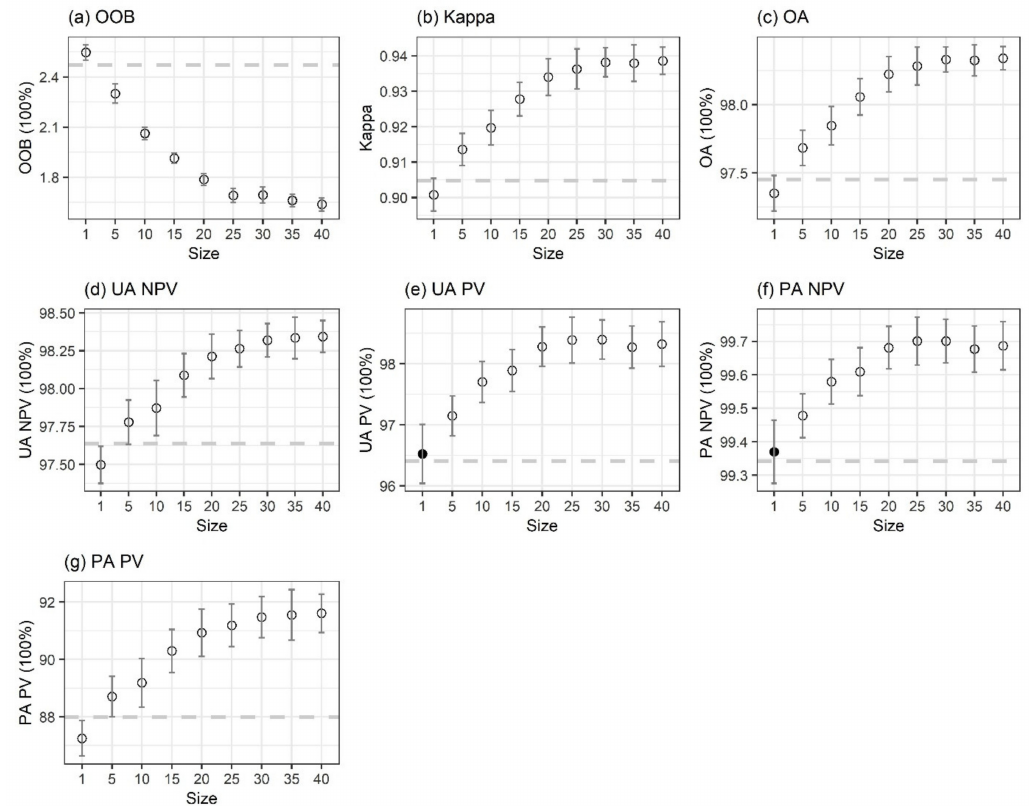
Figure 3. The mean value (dot) and stand deviation (error bar) of ( a ) Out-Of-Bag error (OOB), ( b ) Kappa coefficient, ( c ) Overall Accuracy (OA), ( d ) User’s Accuracy of non-PV power plants (UA NPV), ( e ) User’s Accuracy of PV power plants (UA PV), ( f ) Producer’s Accuracy of non-PV power plants (PA NPV), and ( g ) Producer’s Accuracy of PV power plants (PA PV) for the model trained with spectral variables and textural variables in different GLCM sizes. The dashed line was the mean value for the model trained with only spectral variables. The paired t -test was used to determine the difference between the model trained with only spectral variables and the model trained with spectral and textural variables; black and white points indicated statistically significant at p > 0.01 and p < 0.01 levels,